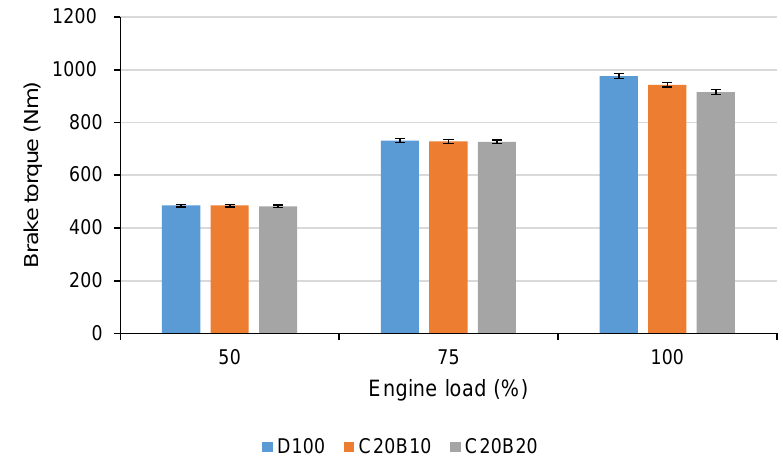
Figure 7. Engine smoke in relation to engine load for all tested fuels (error bars represent the accuracy of the opacimeter).